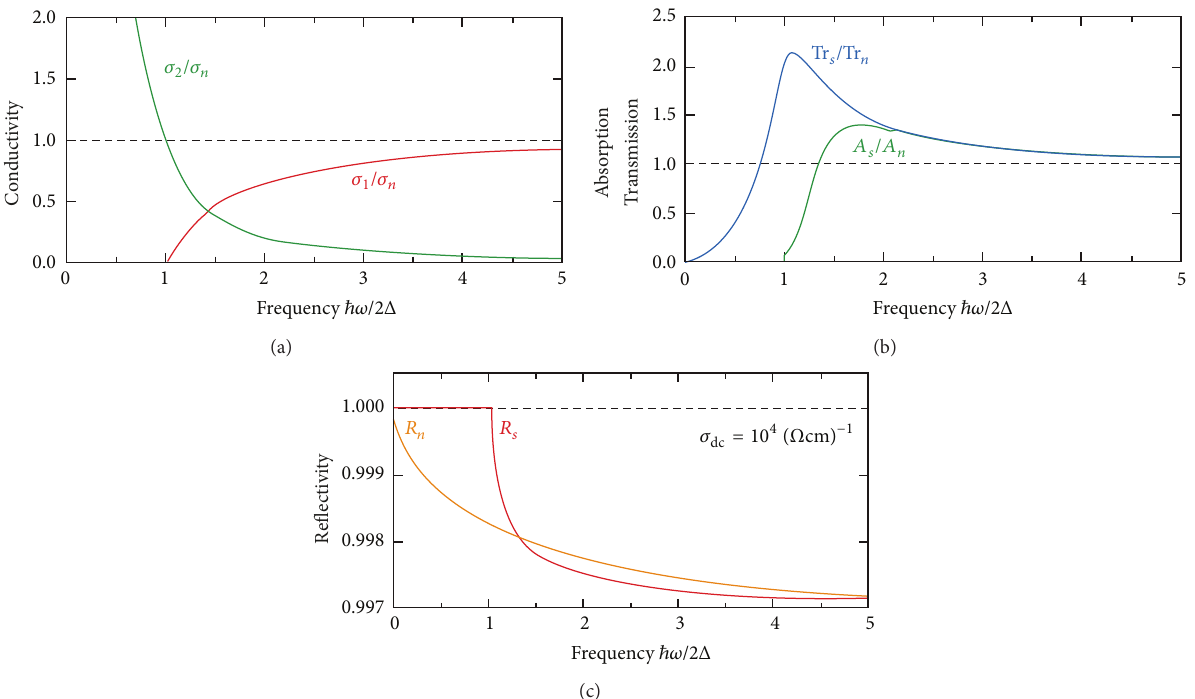
Figure 1: Sketch of the electrodynamic properties of a superconductor at 𝑇 = 0 : (a) in the upper panel the frequency dependence of the real and imaginary parts of the conductivity 𝜎 1 and 𝜎 2 is plotted, normalized to the normal state behavior 𝜎 𝑛 , which basically can be assumed to be constant in the spectral range of interest, where 𝜔 ≪ Γ with Γ the quasiparticle scattering rate. (b) The second panel exhibits the frequency dependence of the relative transmission Tr 𝑠 / Tr 𝑛 and absorption 𝐴 𝑠 /𝐴 𝑛 . (c) The optical reflectivity of a superconductor 𝑅 𝑠 is compared to the reflectivity of a normal metal 𝑅 𝑛 , assuming a dc conductivity of 10 4 (Ω cm ) −1 .